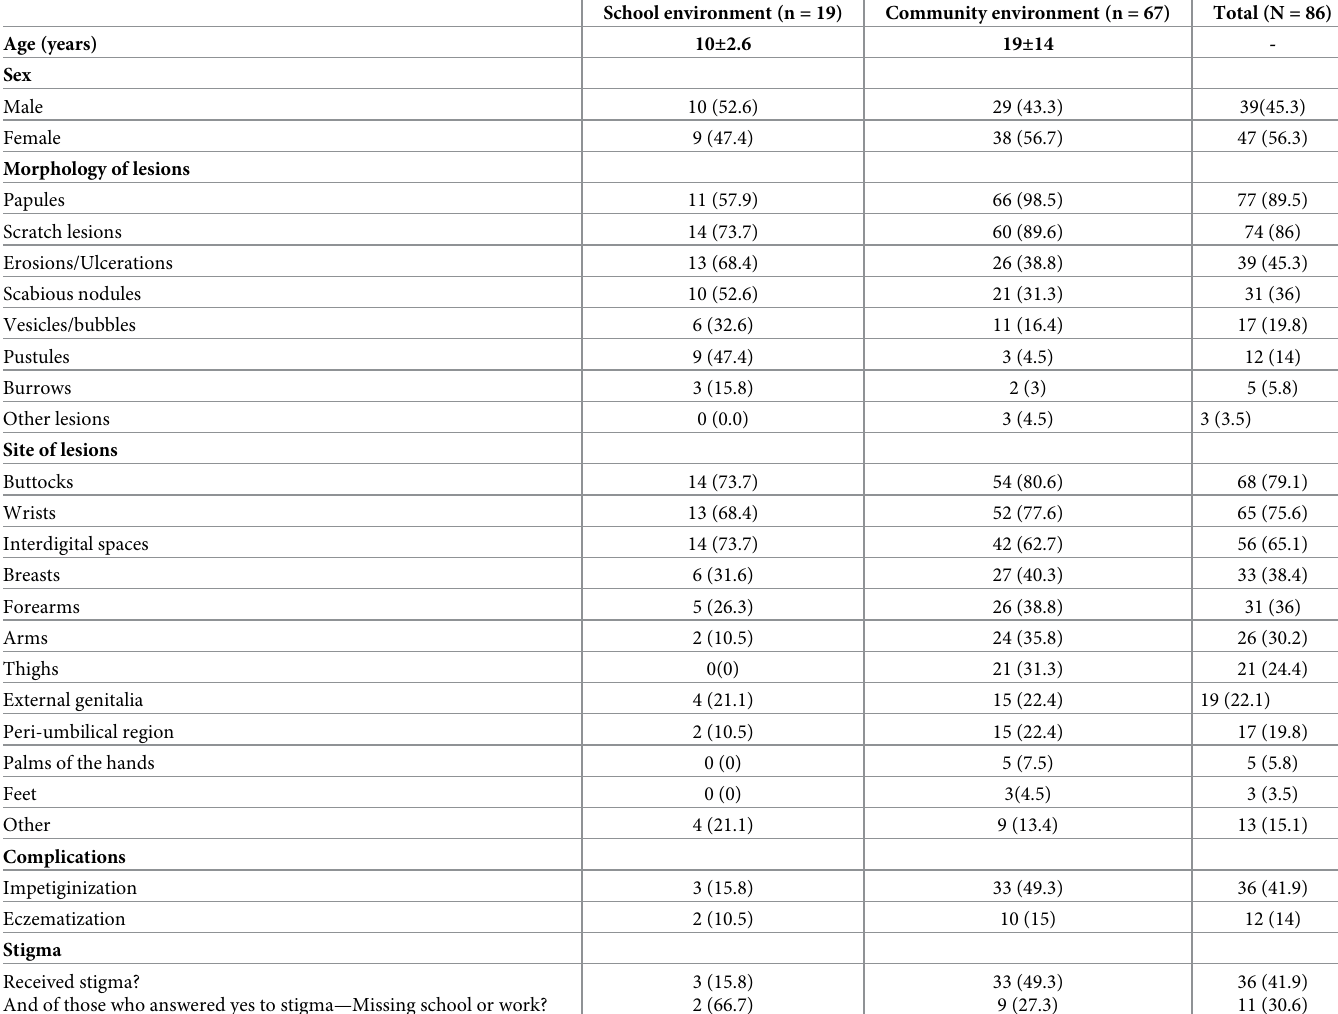
Table 3. Elementary lesions and lesion sites in scabies patients, N